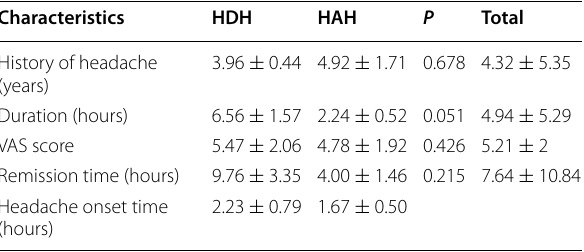
HDH Headache during hemodialysis, HAH Headache after hemodialysis